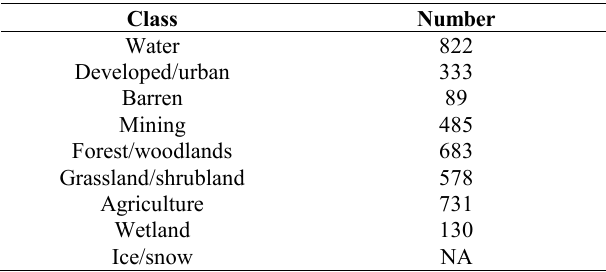
Table 1. 9-catagories used in this study. NA: Not